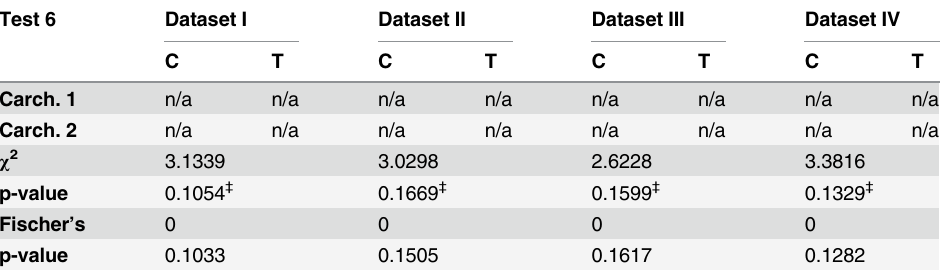
Table 7. Results of Chi-square Test 6 as presented by software R.